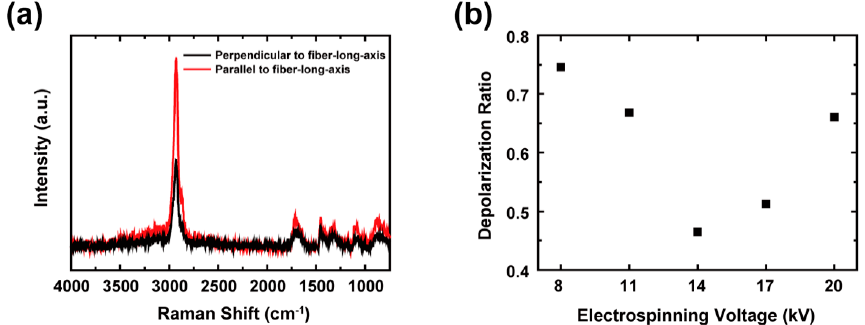
Figure 5. ( a ) Parallel- and perpendicular-polarized Raman spectra for an as-spun PAA NF at 14 kV and ( b ) depolarization ratio of as-spun PAA NFs as a function of electrospinning voltages. The depolarization ratio at 14 kV was the lowest value, which indicates the trans states of molecular chains were most populated at 14 kV.